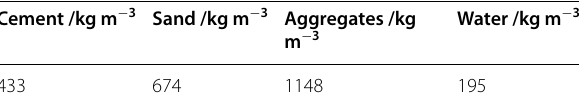
Table 4 Concrete mix proportions.